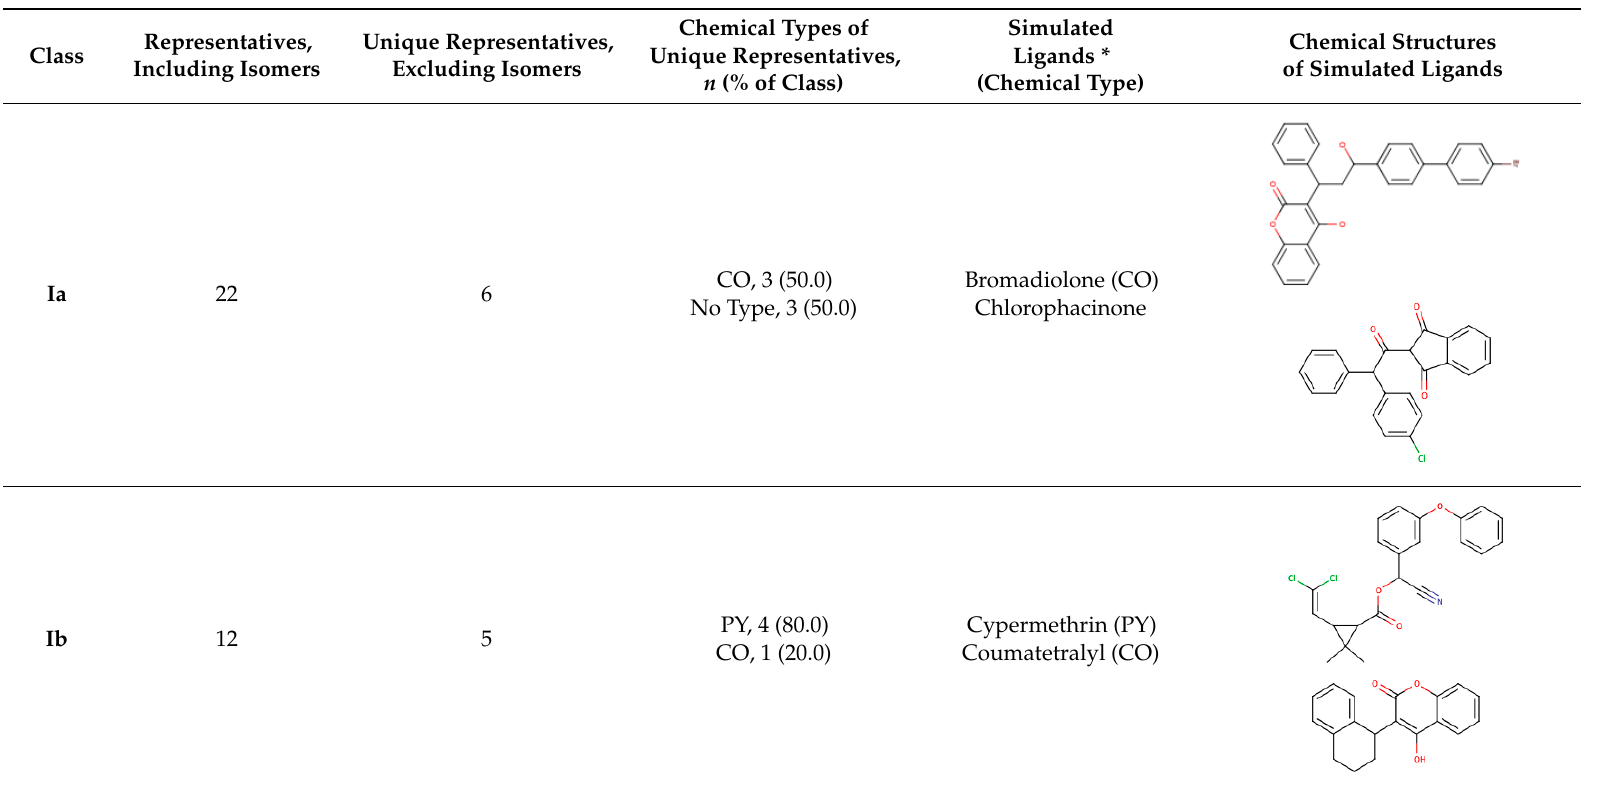
Table 1. A summary of pesticides with binding energies to BLG below − 1 σ (“probable ligands”).